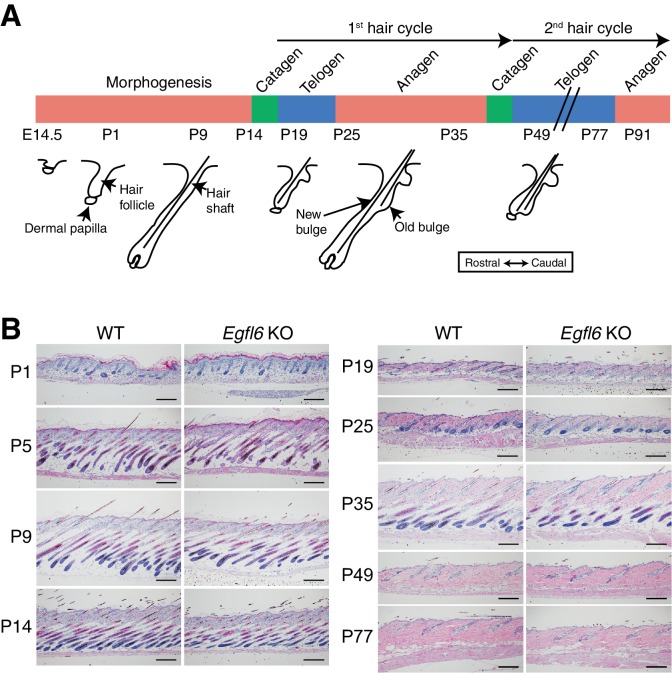
Histological examination of skin tissue morphology in wild-type and Egfl6 knockout mice.(A) Schematic representation of mouse hair follicle morphogenesis and the following regeneration cycles. During the first anagen phase (P25–P35), old and new hair bulge structures form. (B) H&E-stained dorsal skin of wild-type and Egfl6 knockout mice. Scale bars, 100 μm.